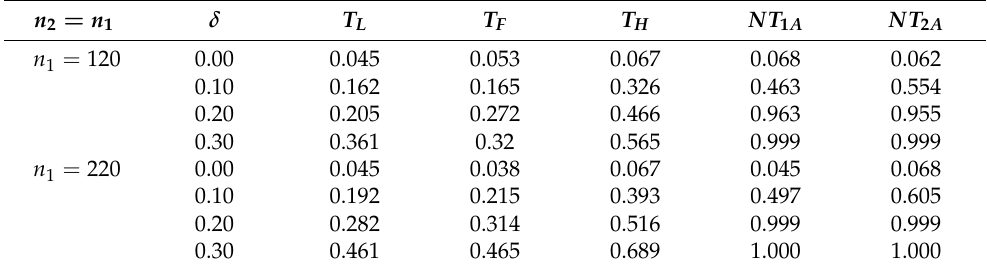
Table 4. Size and power of five methods in Setting 4 (mean difference lies in separable part µ 2 [ 1 : 2 ] = µ 1 [ 1 : 2 ] + δ , µ 2 [ 11 : 12 ] = µ 1 [ 11 : 12 ] + δ , µ 2 [ 21 : 22 ] = µ 1 [ 21 : 22 ] + δ ).